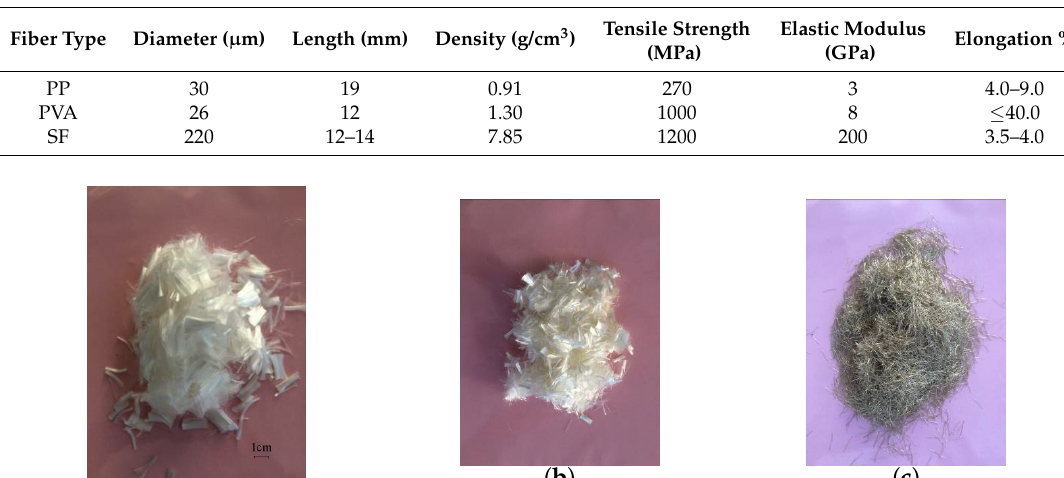
Figure 1. Quartz sand gradation. Table 2. Fiber information.